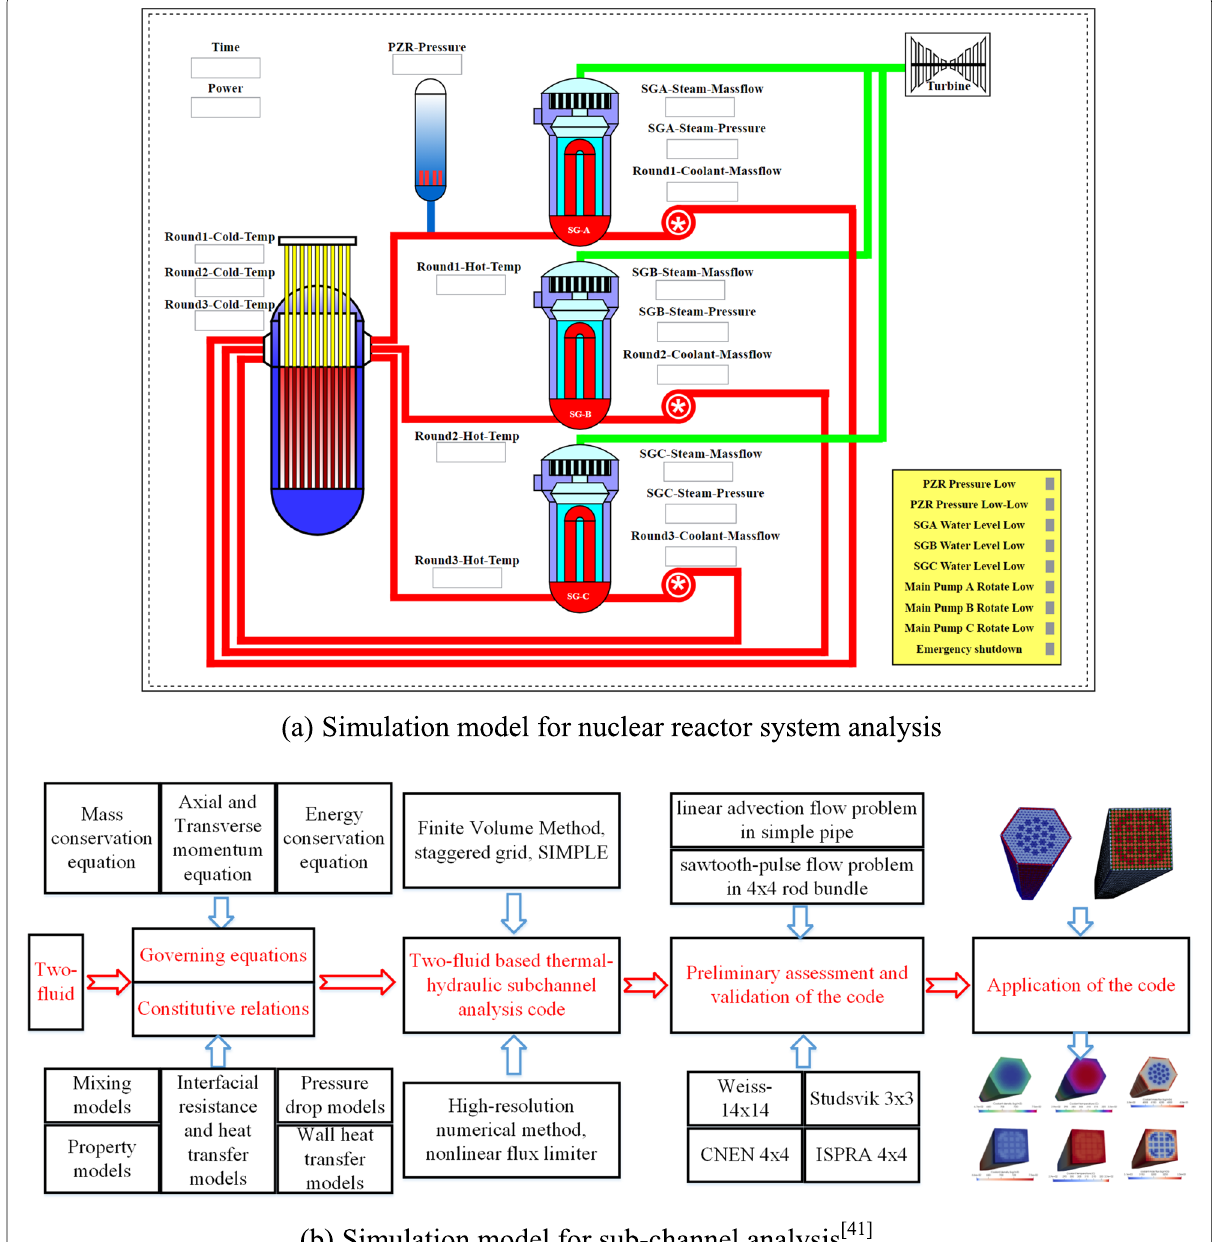
Fig. 4 Simulation models for Gen III PWR. a Simulation model for nuclear reactor system analysis. b Simulation model for sub-channel analysis